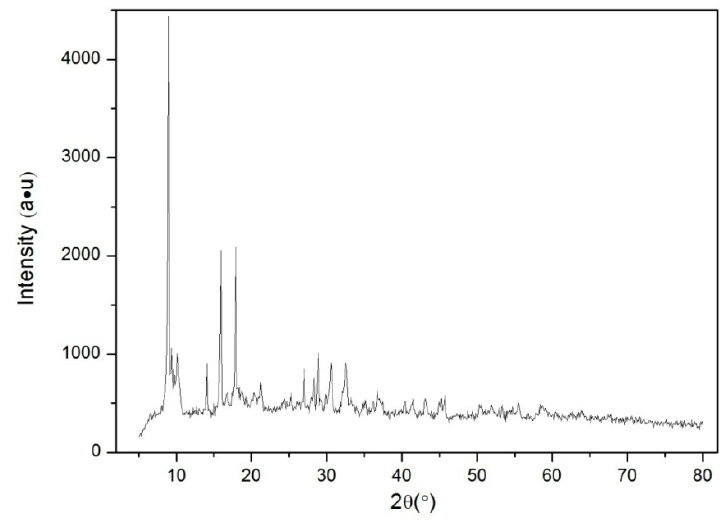
Figure 1. XRD of Fe-MOFs.